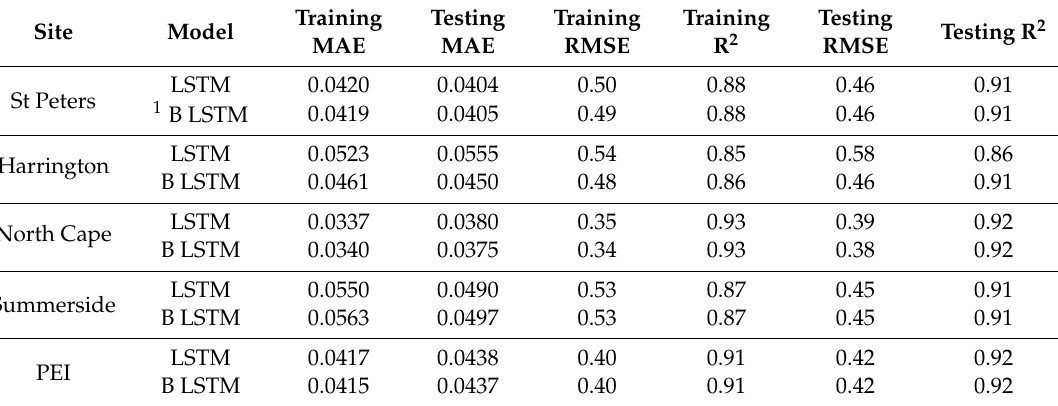
Table 4. Training and testing evaluation of recurrent neural